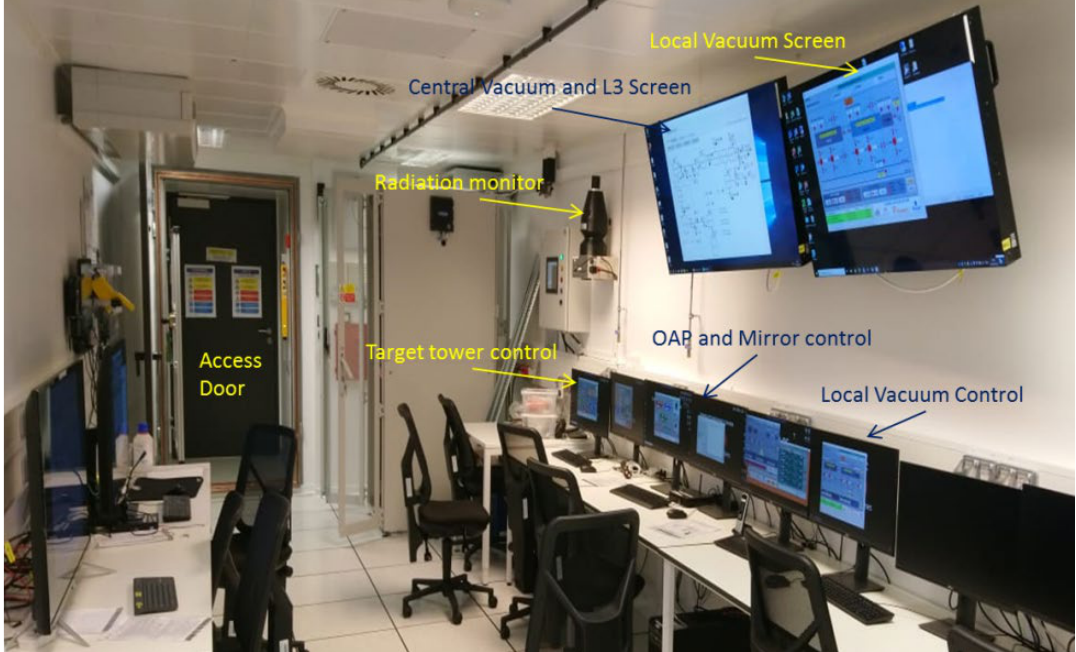
Figure 1. Photo of the E4 local control room. The screens show some key control software (central vacuum and mechanics). The dose rate monitor LB 6419 is visible next to the second large screen on the wall. The E4 hall access is interlocked and has EMP shielding. The graphic interfaces for some of the ELIMAIA controls are detailed in the next